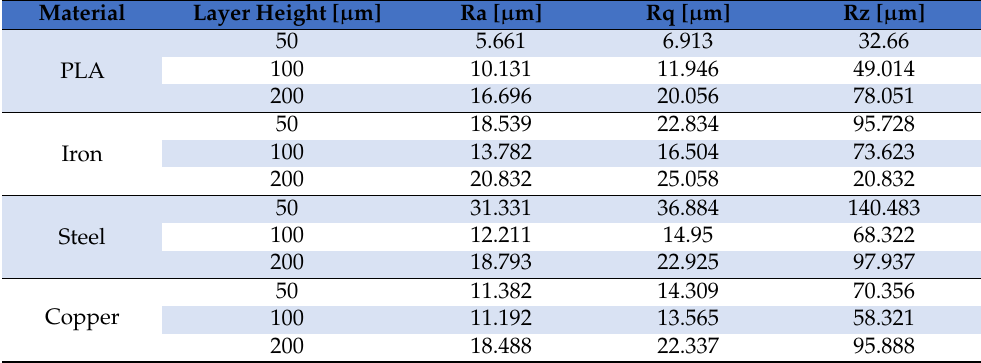
Table 4. Results of surface roughness measurements on the surface directly after 3D